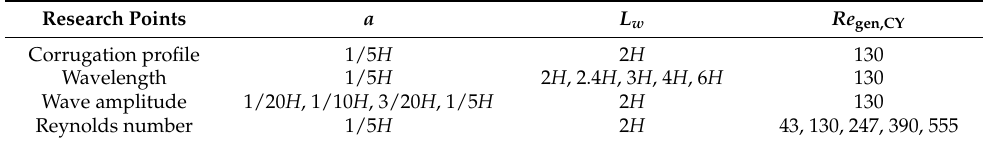
Table 3. Simulation conditions in this study.